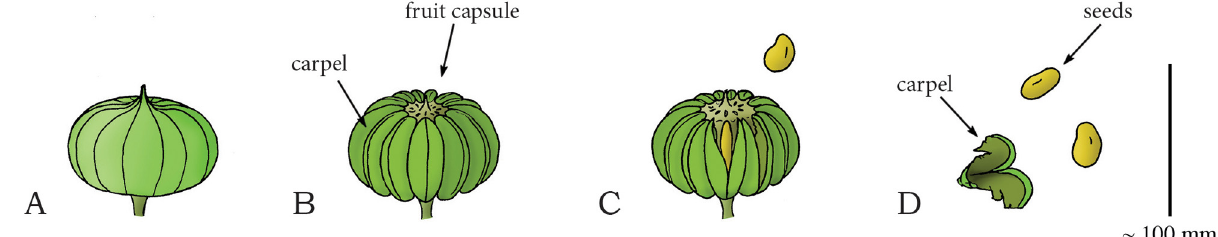
Fig 17. Drying fracture catapult mechanism in the Hura crepitans . (A) The immature fruit of H . crepitans . (B) The full-grown fruit, consisting of several carpels embracing the seeds. (C) When a critical pressure is reached, the carpels split open from the central axis, discharging the seeds. (D) A separated carpel and launched seeds. Drawings based on schematic drawings in [79]. Scale bar 100 mm.